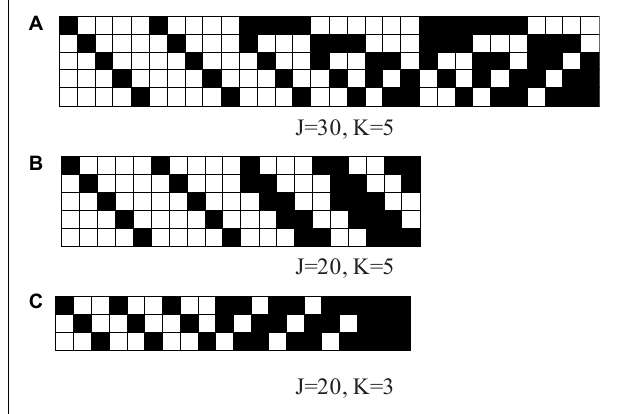
FIGURE 1 | K-by-J Q matrices in simulation studies, where black means “1” and white means “0.” K is the number of attributes and J is the number of